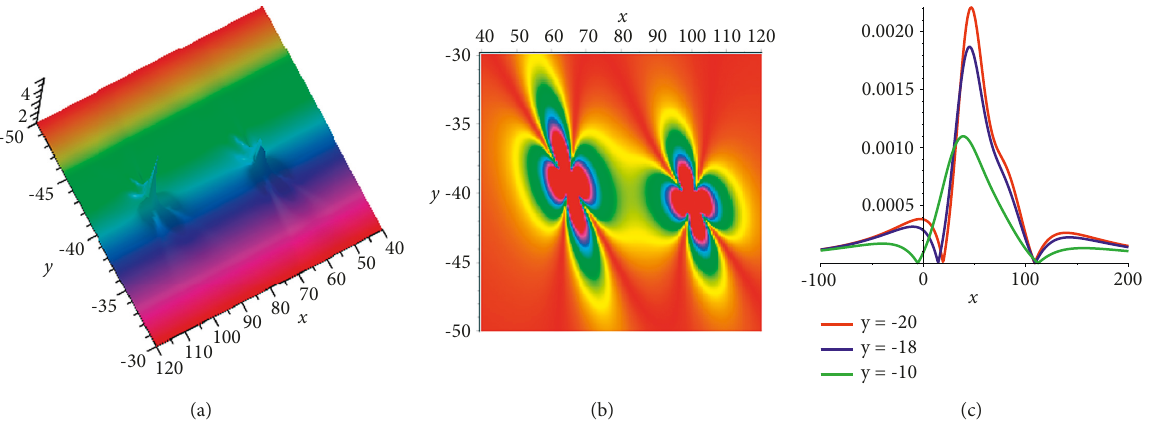
Figure 4: Plot of equation (48) by taking a � 1 , b � 1 . 5 , c � 1 , d � 2 , c